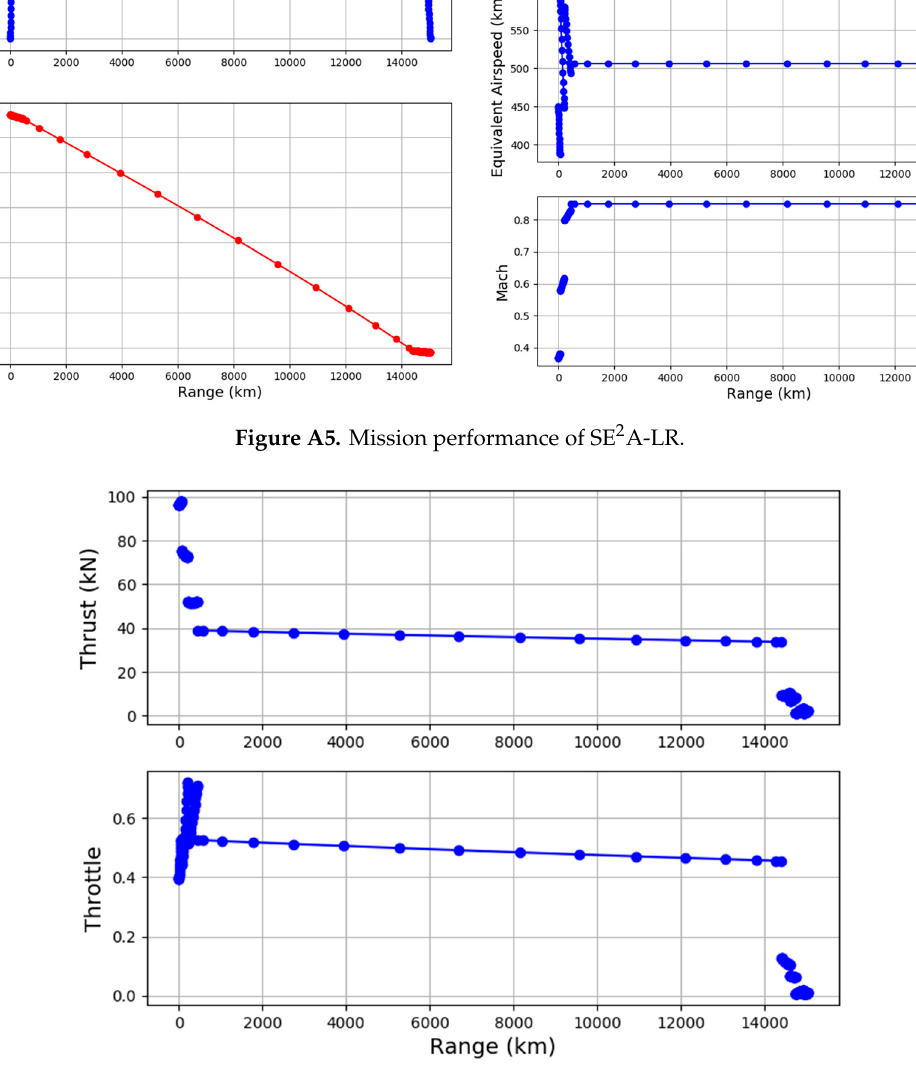
Figure A6. Thrust and throttle settings of SE²A-LR.